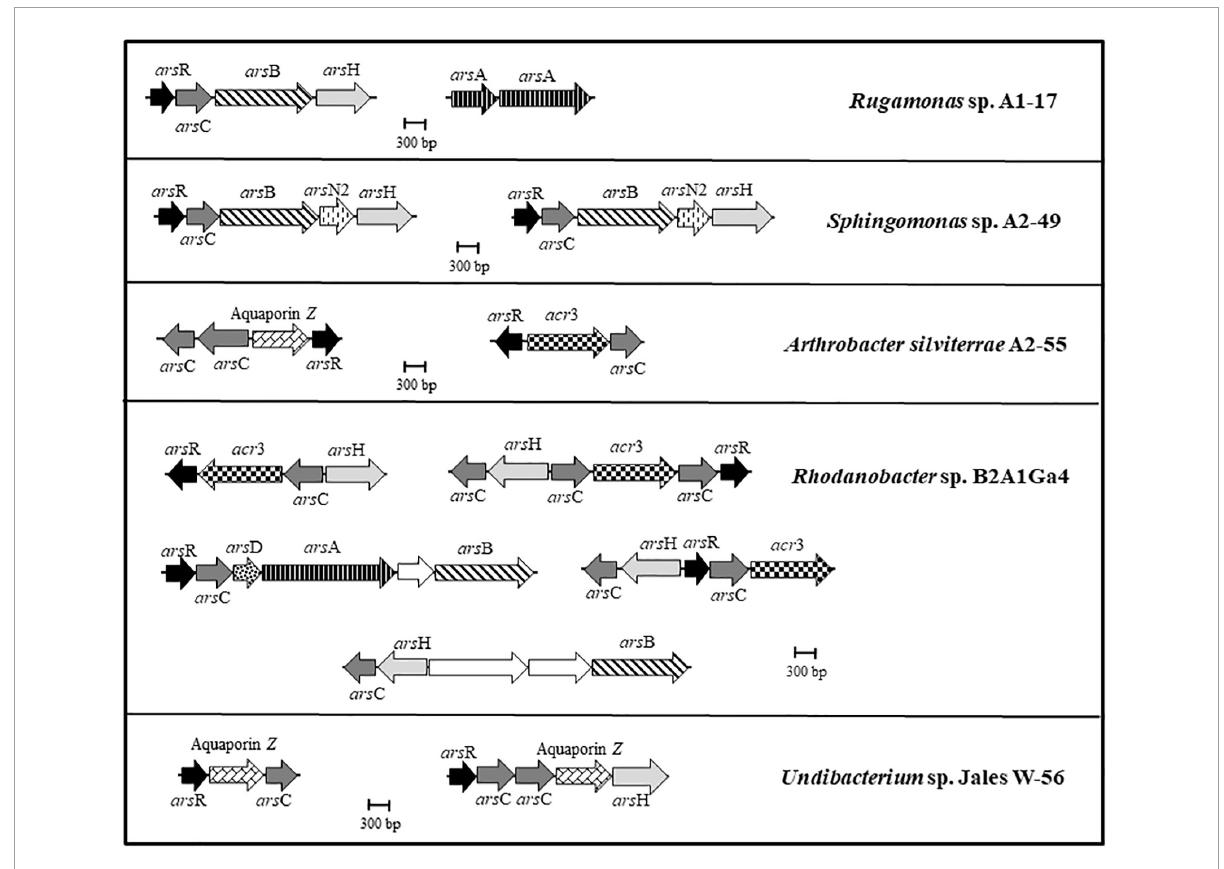
FIGURE2 Genomic organization of the ars gene clusters in the analyzed genomes. Arrows represent different genes, and homologous genes are represented by the same color and pattern, except for the white arrows that represent genes identified as not being related to arsenic